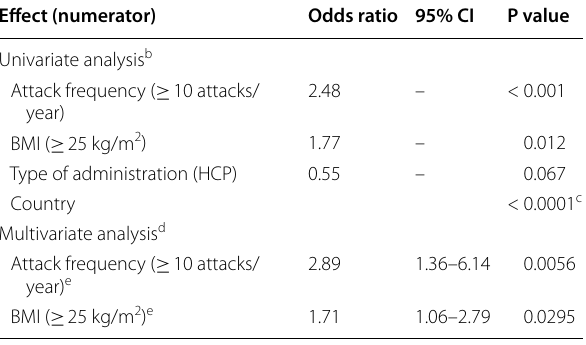
BMI body mass index; CI confidence interval; HCP health care provider a Model of probability that time to treatment < 1 h b